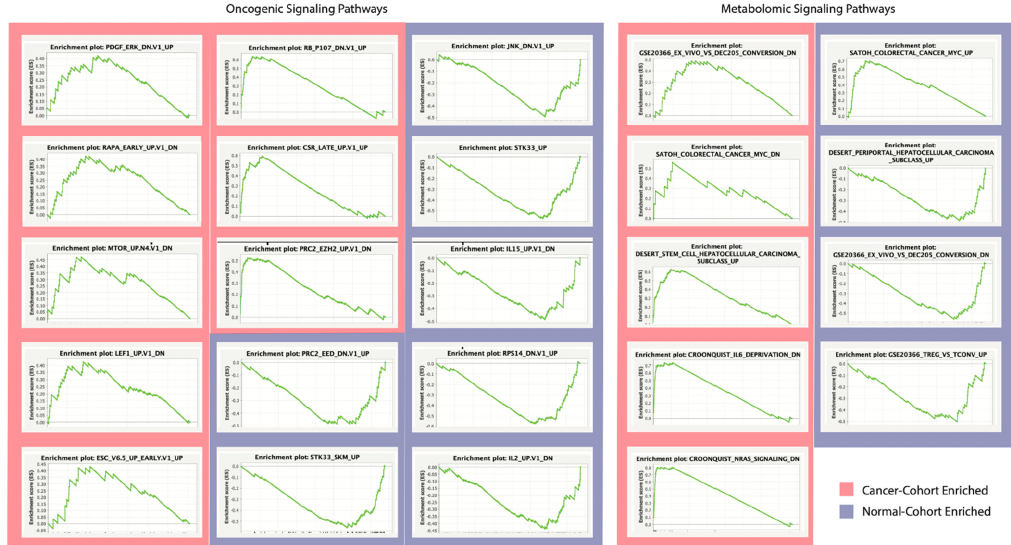
Figure 5. GSEA Enrichment Plots. Gene sets significantly enriched in cancer sample cohorts (red) or normal sample cohorts (blue), with enrichment score magnitude and direction. Division of oncogenic associated and metabolomic associated signaling pathways of enrichment dysregulation. Signaling pathways of the largest peak height exhibit the greatest extent of dysregulation. To understand the extent of significance of correlation between these genes and path- ways, NESs were plotted against each gene set’s nominal p-value and FDR q-value (Figure 6). In comparing LUSC and normal samples, 84 pathways displayed a q-value < 25%, and 40 displayed a p -value < 0.05. Between LUAD and normal samples, 2 displayed a p -value < 0.05.